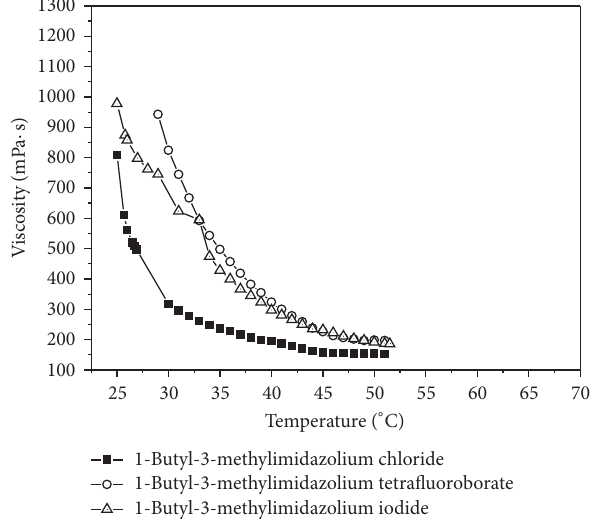
F 7: Viscosities of gel-type electrolytes with different ionic liquids under different temperatures.